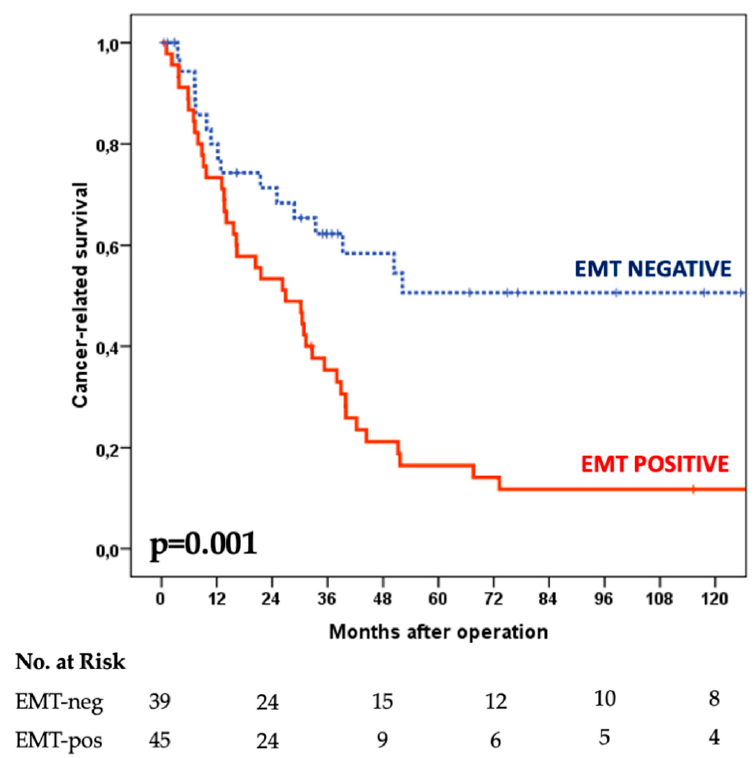
Figure 4. Cancer-specific survival according to EMT status in MSS diffuse-type tumors; the difference is statistically significant (Log-rank test). Table 2. Five-year cancer-specific survival probability according to EMT status, stratified for the main clinical-pathological factors.